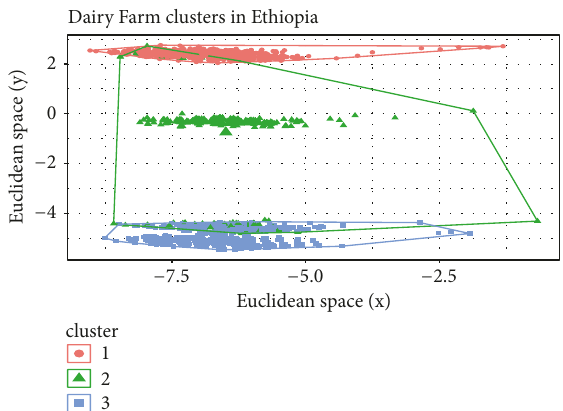
Figure 5: Household allocation into three clusters using the fuzzy model for Ethiopia dairy farmers.